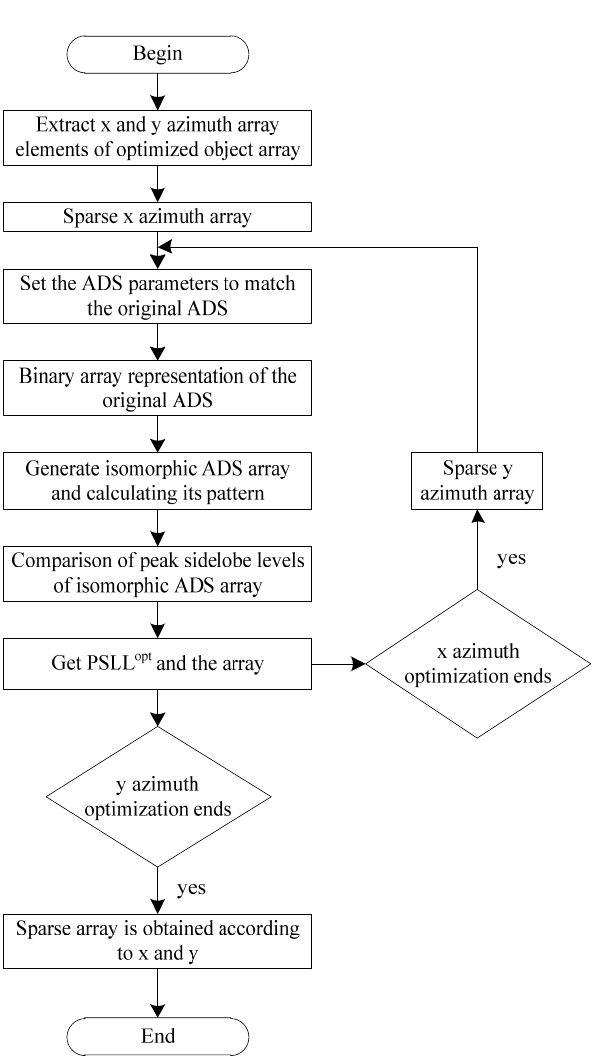
Figure 4. Almost Different Set s (ADS) optimization procedure for a Mills Cross array. Figure 4. Almost Di ff erent Sets (ADS) optimization procedure for a Mills Cross